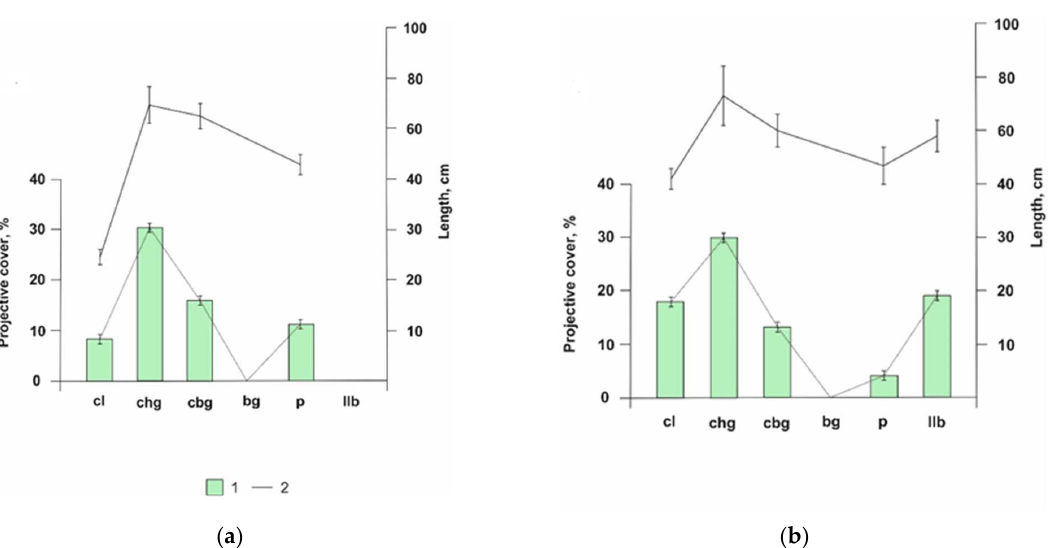
Figure 5. Average projective cover and C. vulgaris shoot length in geographically vicarious types of pine forests of ( a ) Pritobolye, Western Siberia, and ( b ) Baltic, Eastern Europe. 1—Projective cover;